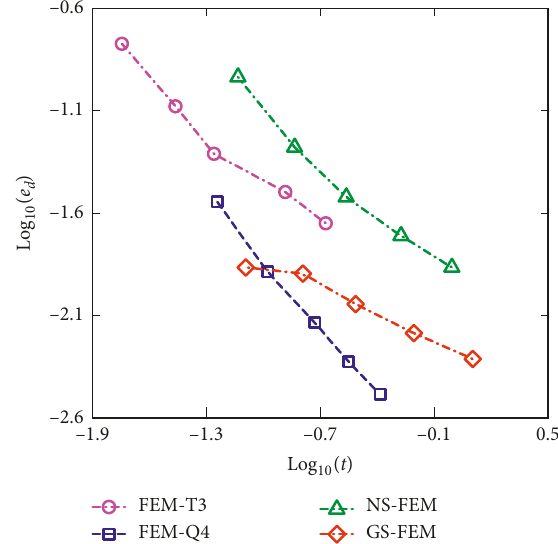
Figure 12: Displacement error norm with respect to computation time.